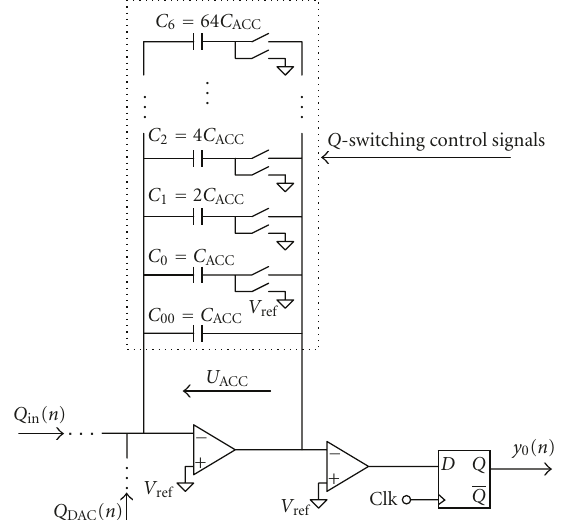
Figure 6: Charge accumulation with variable integration capaci- tance (“ Q